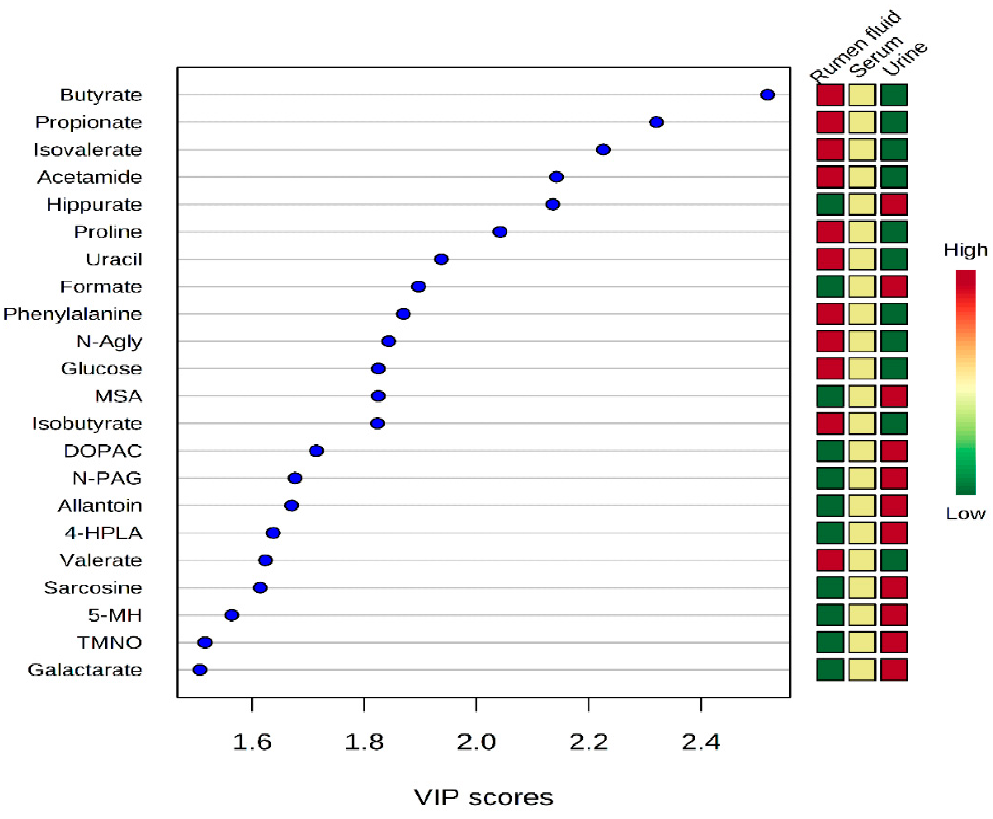
Figure 4. Variable importance in projection (VIP) scores of metabolites in rumen fluid, serum, and urine by 1 H-NMR spectroscopy analysis. The selected metabolites were those with VIP > 1.5. Heat map with red, yellow, and green boxes on the right indicates high, medium, and low abundance ratio, respectively, of the corresponding metabolites in rumen fluid, serum, and urine. VIP score was based on the PLS-DA model. VIP score value: butyrate, 2.519; propionate, 2.3206; isovalerate, 2.2261; acetamide, 2.1425; hippurate, 2.1361; proline, 2.042; uracil, 1.9373; formate, 1.8968; phenylalanine,